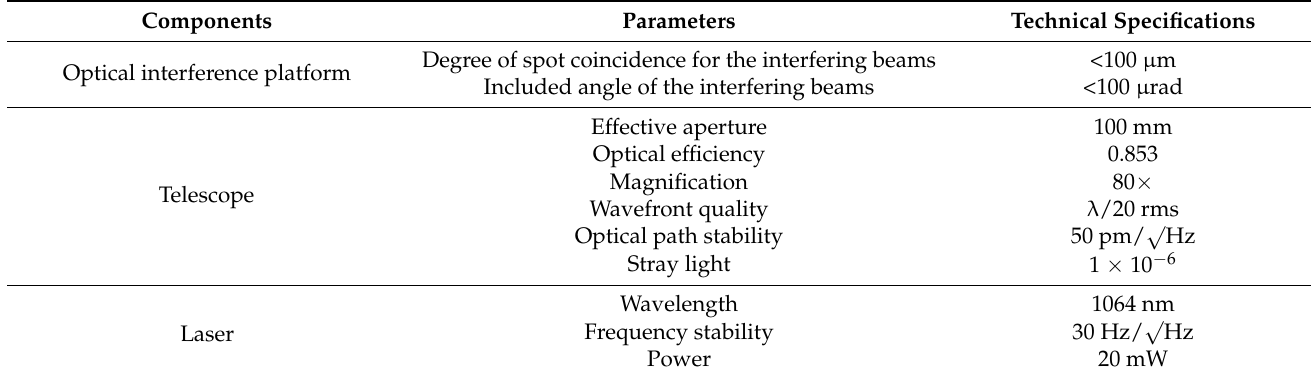
Table 5. Main parameters of the optical interference platform, telescope, and laser. Components Parameters Technical